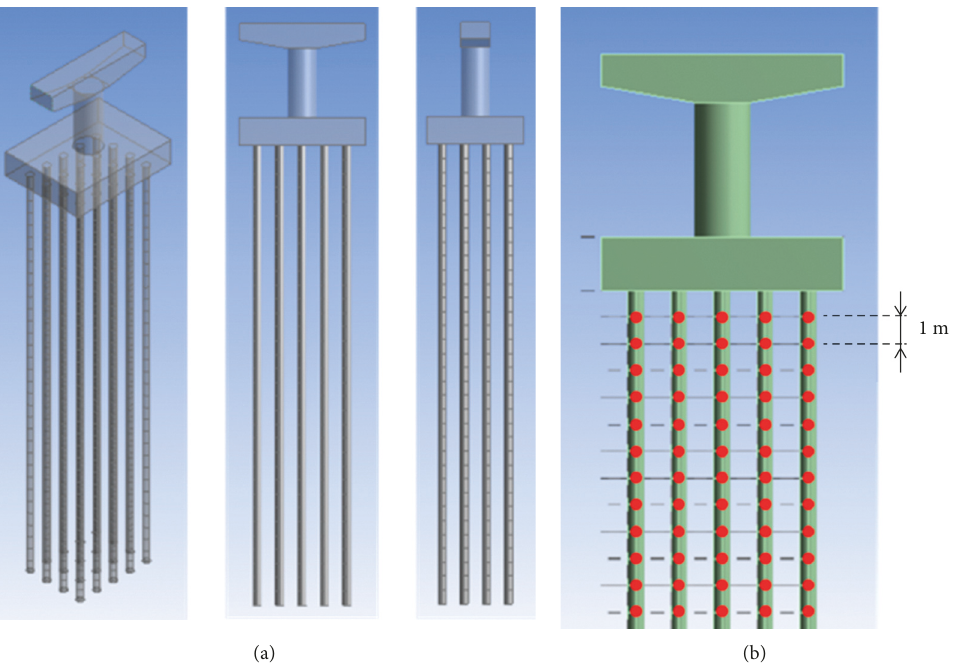
Figure 11: Numerical model of the Shi-Bin Bridge. (a) Column and piles. (b) Arrangement of soil